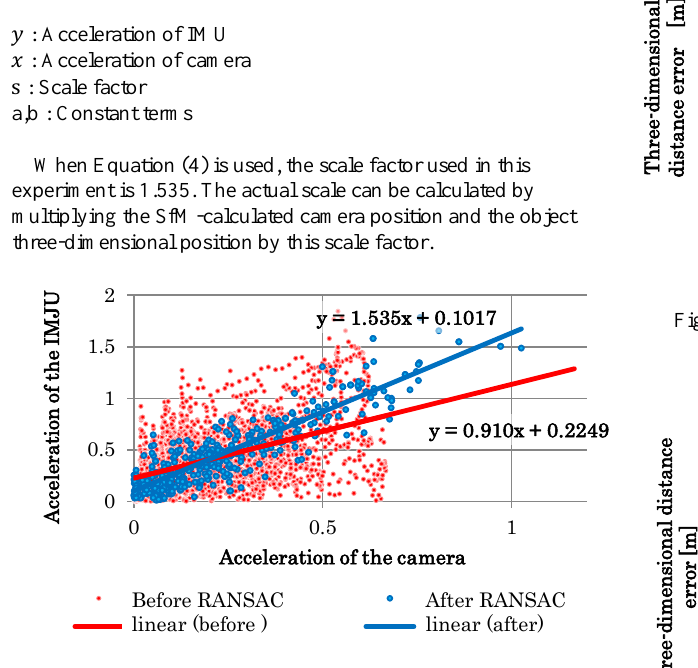
Fig. 16 Correlation diagram after RANSAC processing